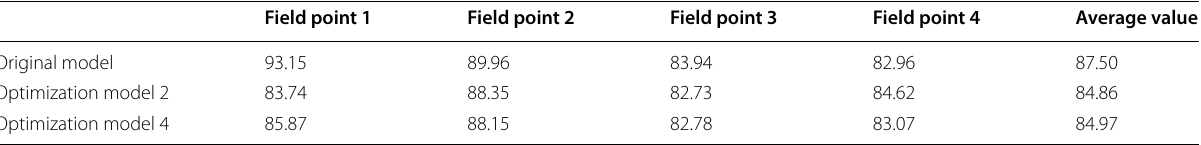
Table 6 Comparison of measured values of effective sound pressure level of radiated noise at four field points before and after optimization of test gearbox